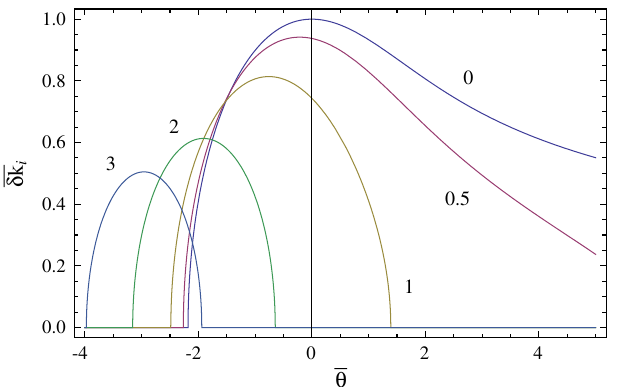
ffiffiffi p 3 (cid:2) i ,